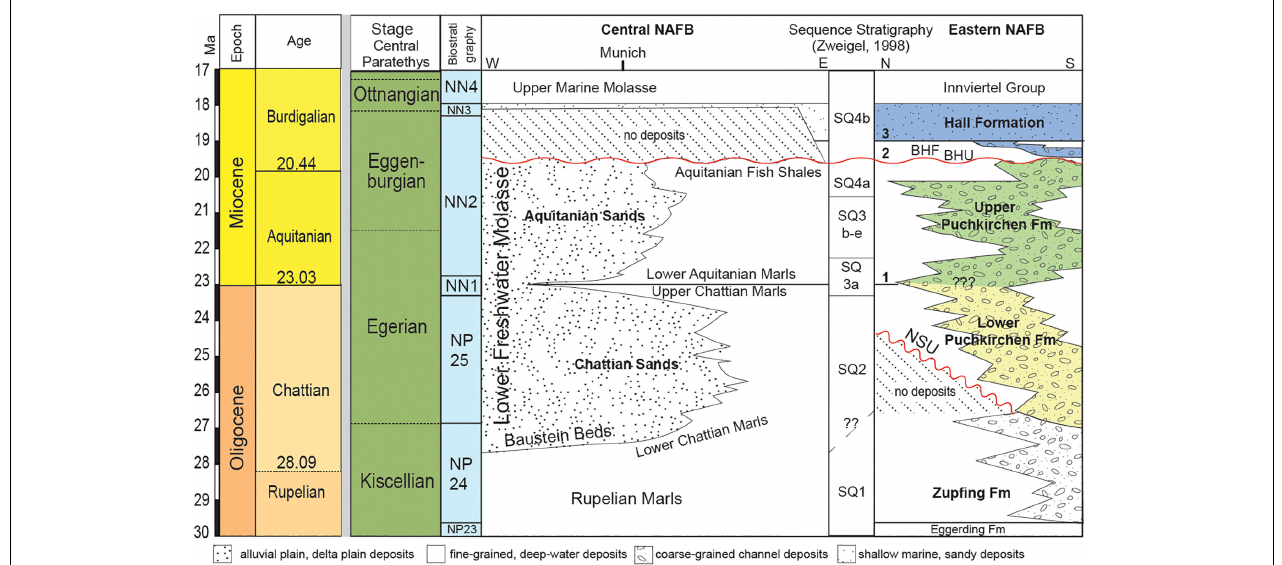
FIGURE 3 | Schematic correlation of the global stages (Gradstein et al., 2012), the stages of the Central Paratethys (Piller et al., 2007), the calcareous nannoplankton after Backman et al. (2012) and Agnini et al. (2014), the stratigraphic and facies evolution (from W to E) in the central NAFB (Kuhlemann and Kempf, 2002), the sequence stratigraphy for the eastern NAFB (Zweigel, 1998), and the stratigraphy and facies evolution (N-S cross section) in the deep-marine Puchkirchen Trough. Depositional ages of the Eggerding and Zupfing Fm from Sachsenhofer et al. (2010) and Soliman (2012). Please note: Correlation between the eastern and the central NAFB is highly speculative. Only the Oligocene/Miocene (1) boundary (SQ 3a), the BHU (2), and the maximum flooding surface (mfs) in the HFM (3) can be used as reliable temporal